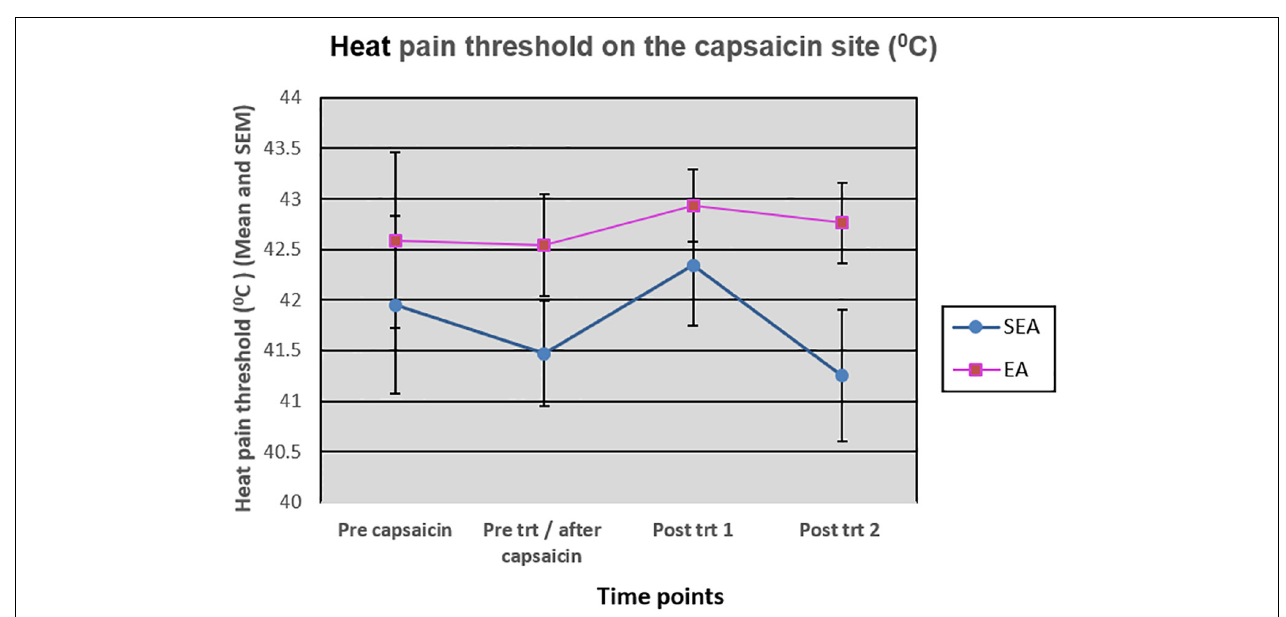
FIGURE 6 | Heat pain threshold on the capsaicin site before capsaicin, before intervention/after capsaicin (Pre trt/after capsaicin), immediately after (Post trt 1), and 90 min after (Post trt 2) intervention in REA and SEA groups. Data are expressed as mean ±